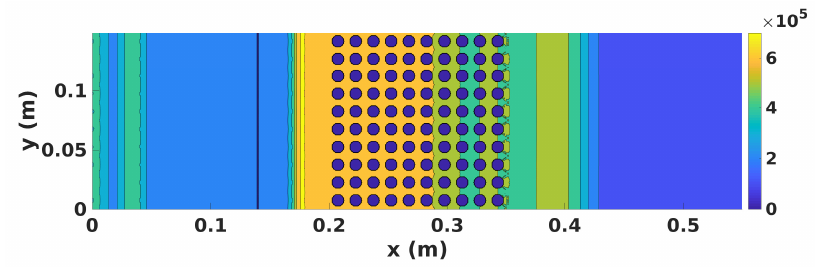
Figure 8. Reference pressure field (Pa) - t = 2.4 × 10 − 4